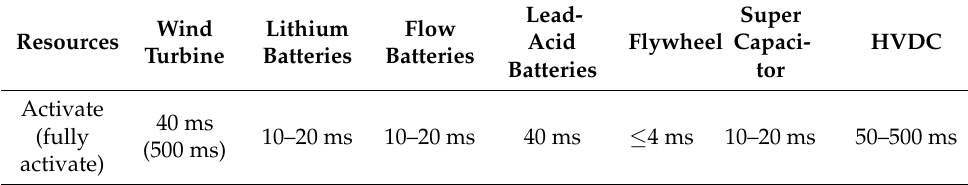
Table 1. Activation time for various resources [13].